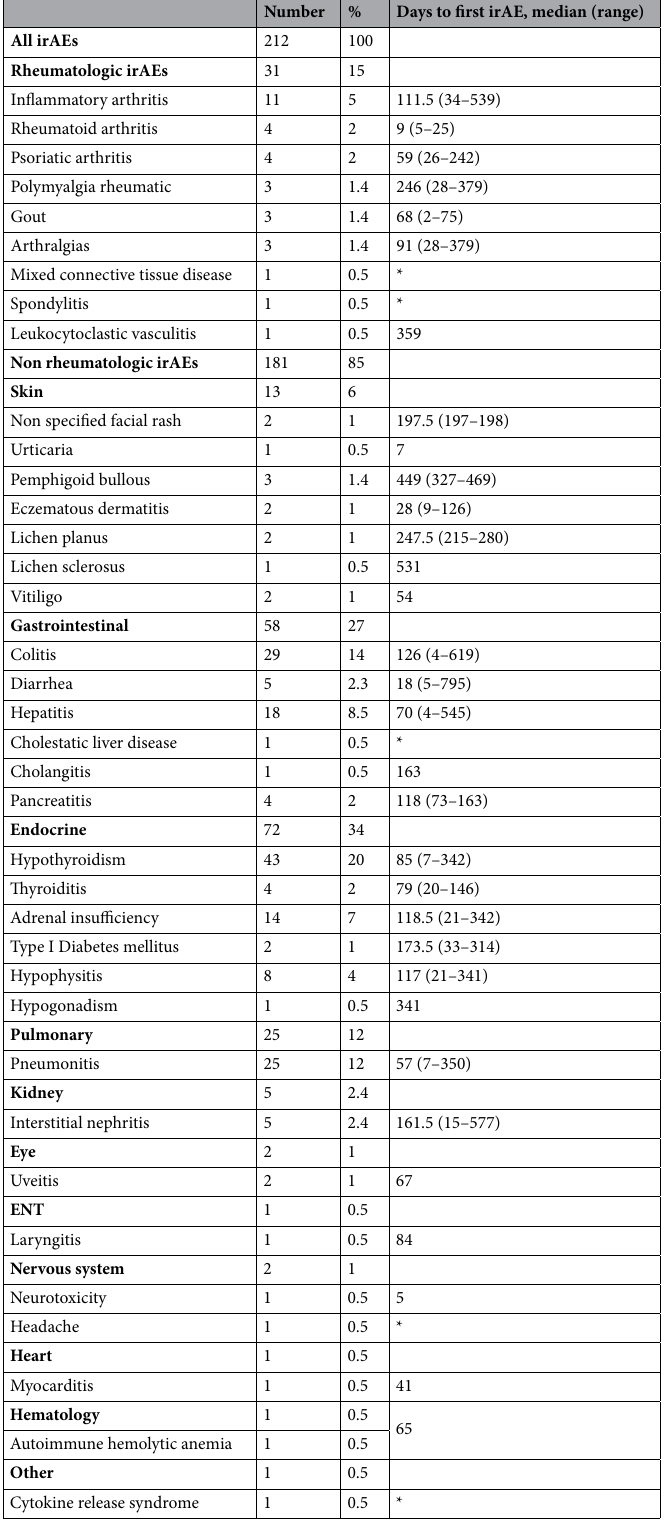
Table 2. Summary of rheumatologic and non-rheumatologic irAEs. irAEs immune related adverse events. * it was not the first